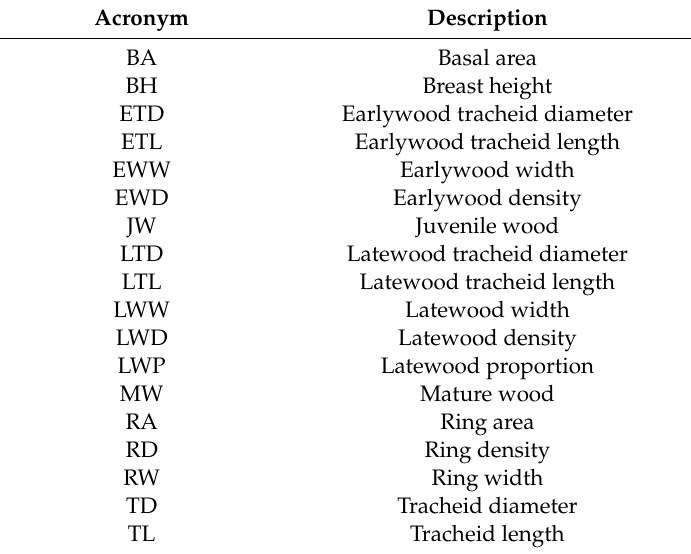
Table 1. Acronyms used in the text and their